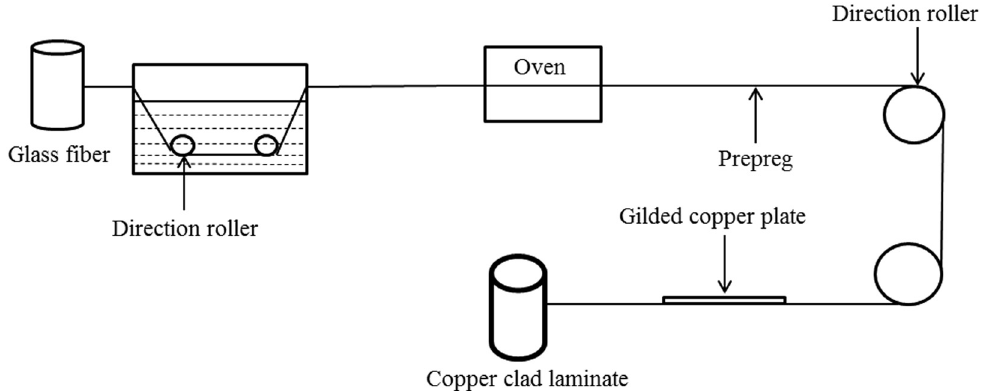
Figure 1: The production process of copper clad laminate ( CCL )